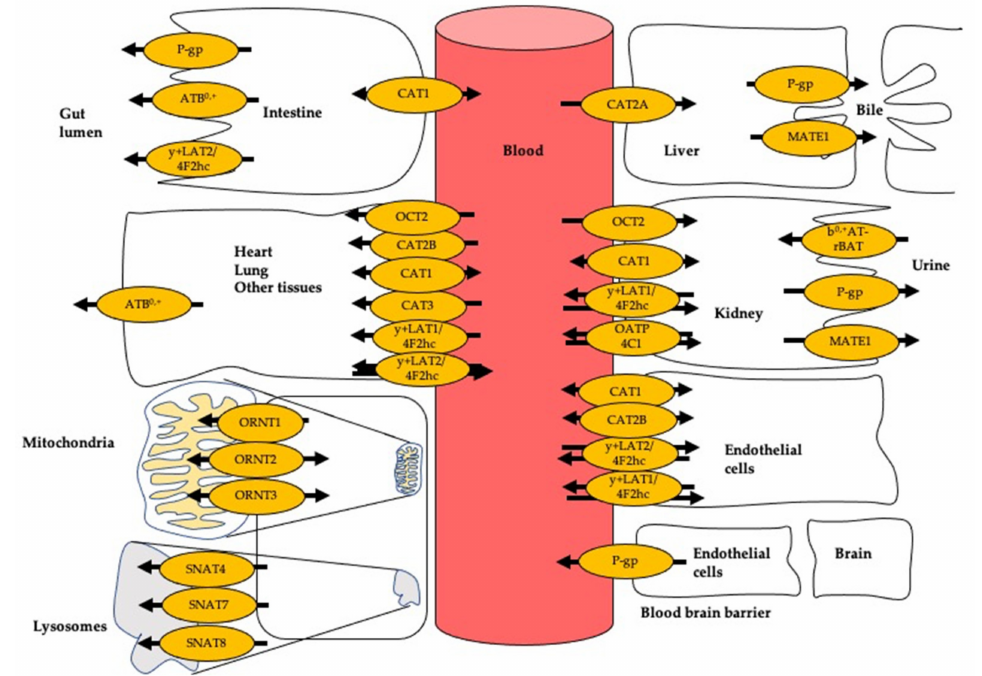
Figure 2. Transport of L-arginine and its derivatives in di ff erent cell types. Arrow indicates the direction of transport. ATB 0, + : amino acid transporter responsible for the activity of system B 0, + ; CAT1: cationic amino acid transporter 1; CAT2A and CAT2B: cationic amino acid transporters 2A and 2B; MATE1: multidrug and toxin extrusion protein 1; OATP4C1: organic anion-transporting polypeptide 4C1; OCT2: organic cation transporter 2; ORNT1: ornithine transporter 1; ORNT2: ornithine transporter 2; ORNT3: ornithine transporter 3; P-gp: P-glycoprotein; SNAT7: sodium-coupled neutral amino acid transporter 4; SNAT7: sodium-coupled neutral amino acid transporter 7; SNAT8: sodium-coupled neutral amino acid transporter 8; y + LAT1: system y + L amino acid transporter 1; 4F2hc: 4F2 cell surface antigen heavy chain; y + LAT2: system y + L amino acid transporter